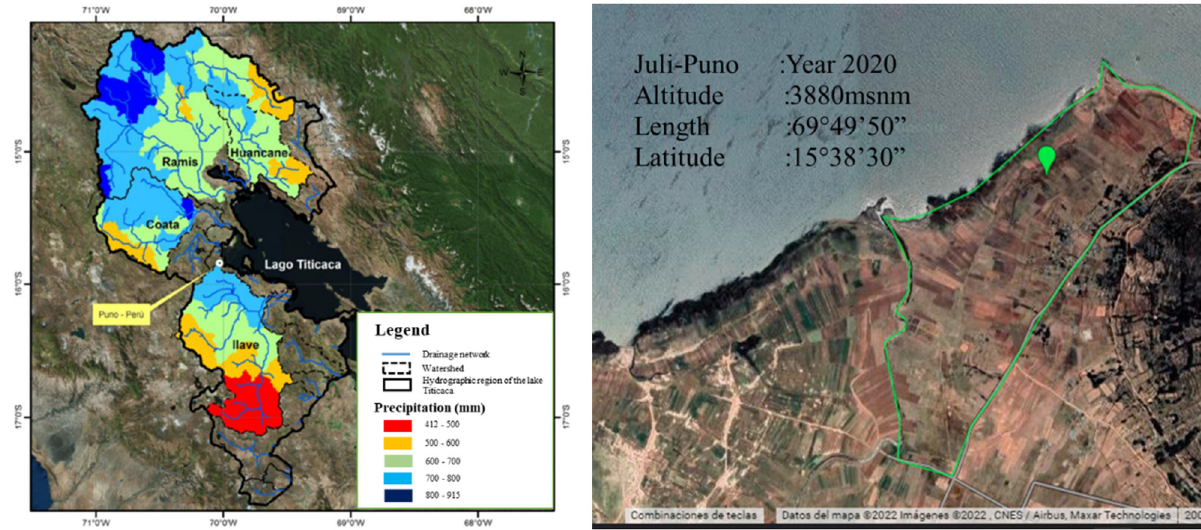
Figure 3: Location of the research site obtained from Google Earth Engine.